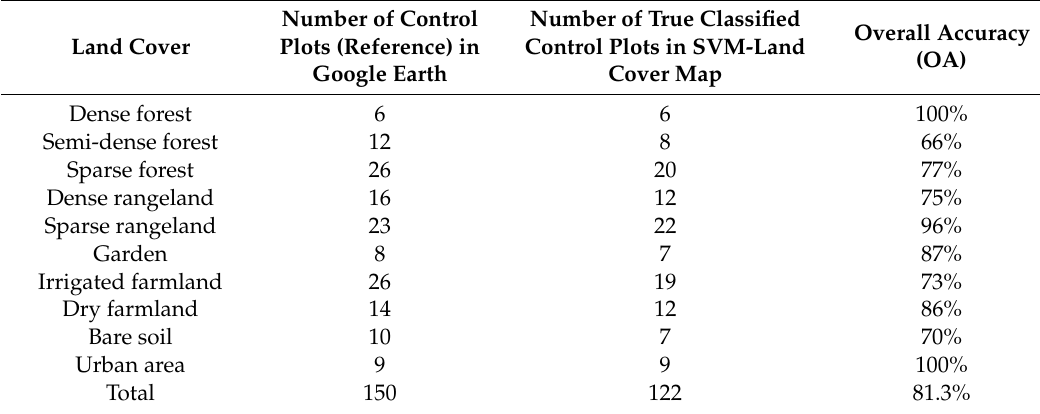
Table 6. Accuracy assessment of land covers obtained from the SVM algorithm by Google Earth data. Number of True Classified Number of Control Control Plots in SVM-Land Land Cover Plots (Reference) in Cover Map Google Earth